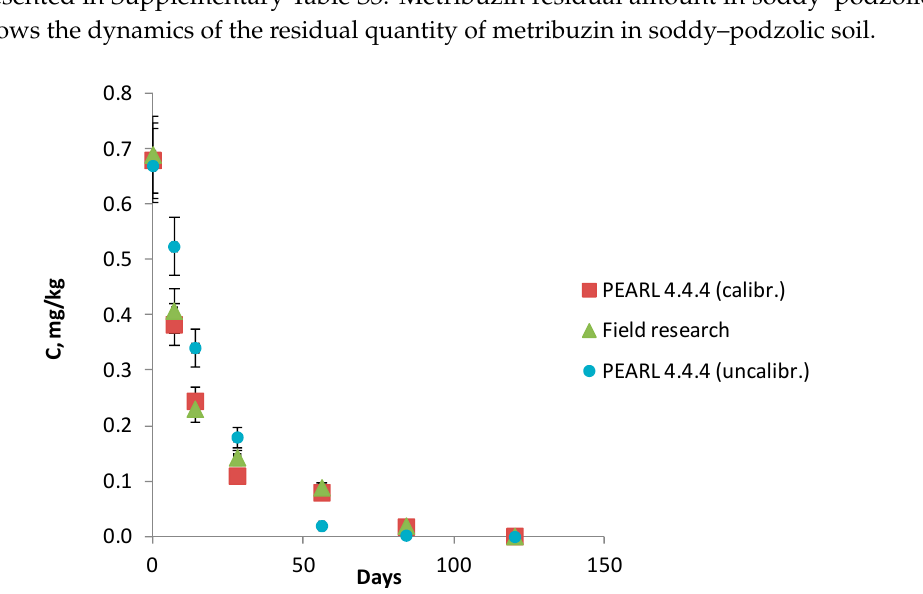
Figure 2. Dynamics of the residual amount of metribuzin in soddy–podzolic soil. Error bars indicate the confidence interval at α = 0.05.